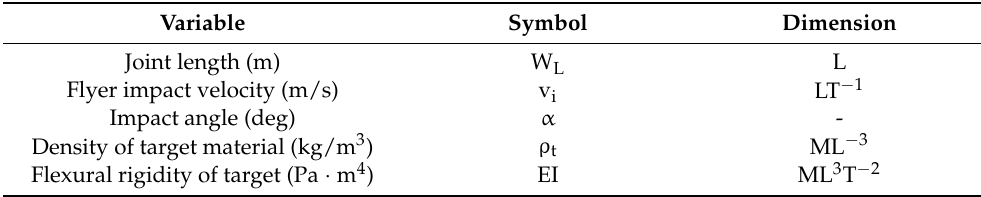
Table 4. Variables and their corresponding dimensions in the MLT system for the dimensional analysis of the weld joint length (W L ) for MPW of tubes and sheets. Variable Symbol Dimension Joint length (m) W L L Flyer impact velocity (m/s) v i LT − 1 Impact angle (deg) α - Density of target material (kg/m 3 ) ρ t ML − 3 Flexural rigidity of target (Pa · m 4 ) EI ML 3 T −